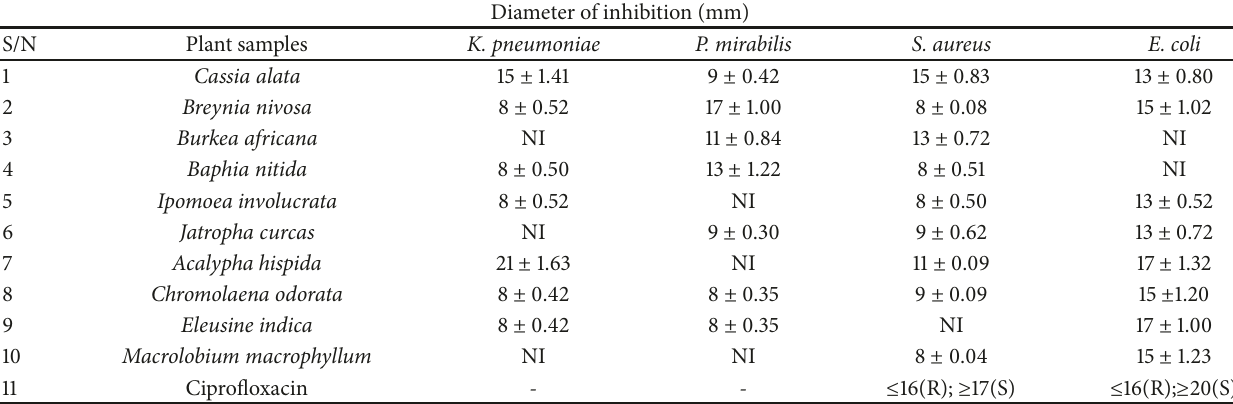
Table 4: Zone of bacterial inhibition by the selected plant extracts use in the management of oral and skin infections. Diameter of inhibition (mm)